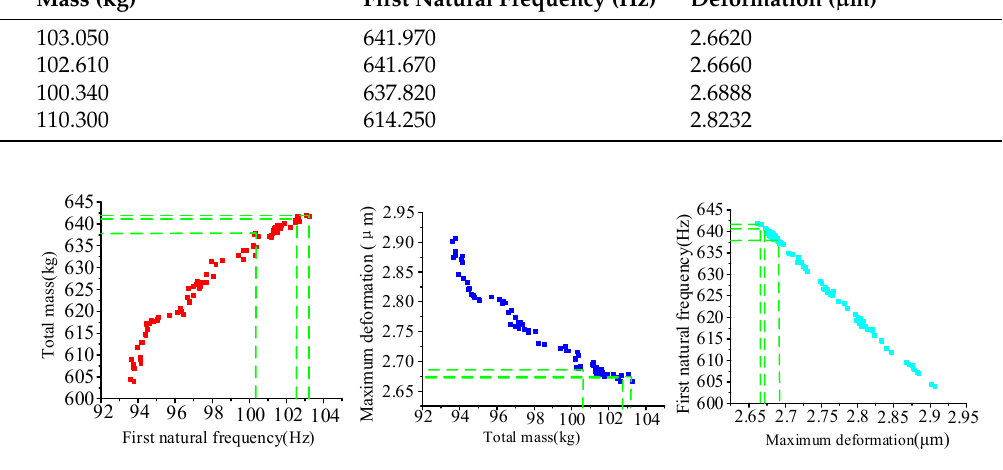
Figure 31. NSGA-II Pareto solution.